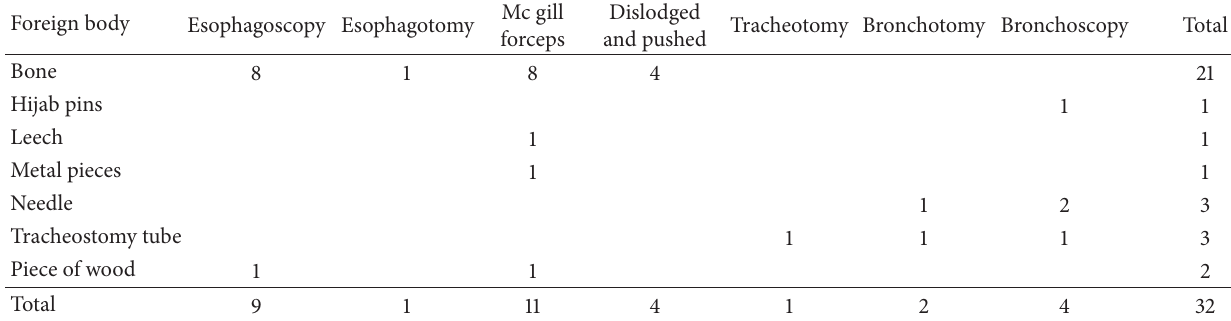
Table 3: Types of foreign bodies and techniques of extraction in Addis Ababa, 2011-2012. Foreign